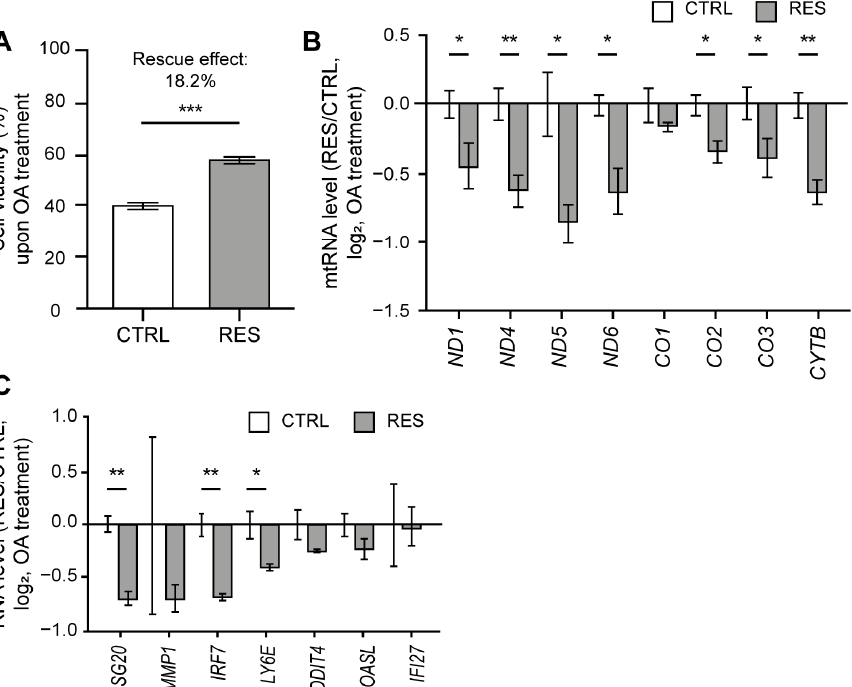
Figure 4. RES treatment alleviated cell death and IFN response to OA. ( A ) Cell viability upon OA treatment with or without RES treatment measured using a SRB assay. ( B ) The ratios of mtRNA induction upon OA treatment between RES-treated and control samples. ( C ) The ratios of ISG induction upon OA treatment between RES-treated and control samples. For ratios, Cq values were first normalized to that of ACTB mRNA. For untreated samples, the values were normalized to RNAs from control cells without OA treatment. Similarly, RNAs from cells co-treated with RES and OA were normalized separately from those from cells treated only with RES without OA. Unless mentioned otherwise, three independent experiments were carried out, and error bars denote s.e.m. All statistical significances were calculated using one-tailed Student’s t -tests; * p ≤ 0.05, ** p ≤ 0.01, and *** p ≤ 0.001.